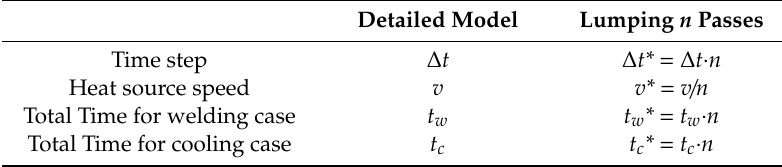
Table 4. Changed time and velocity settings when lumping